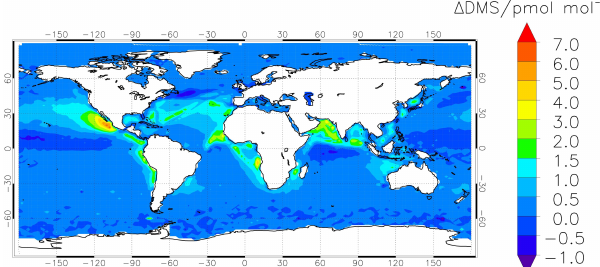
Figure 9. Increase in the DMS levels during nighttime (from 00:00 to 01:00LT) at the surface level due to the inclusion of the Reac- tions (R1) and (R4) in CAM-Chem.